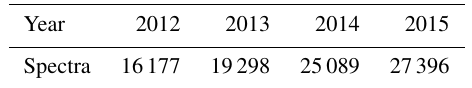
Figure 1. Antarctica elevation map, with Concordia Station indi- cated by a red star. Table 1. Number of analyzed REFIR-PAD spectra for each